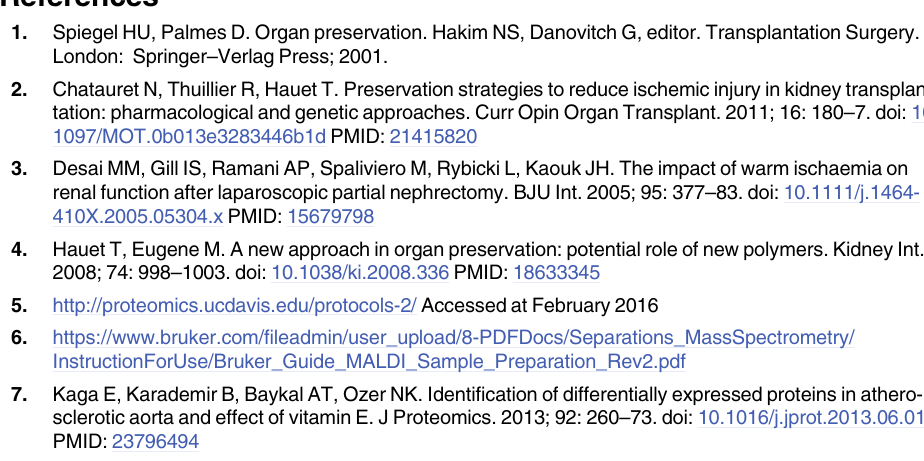
S1 Table. Main Dataset. Proteins and peptides isolated from preservation solution of kidneys